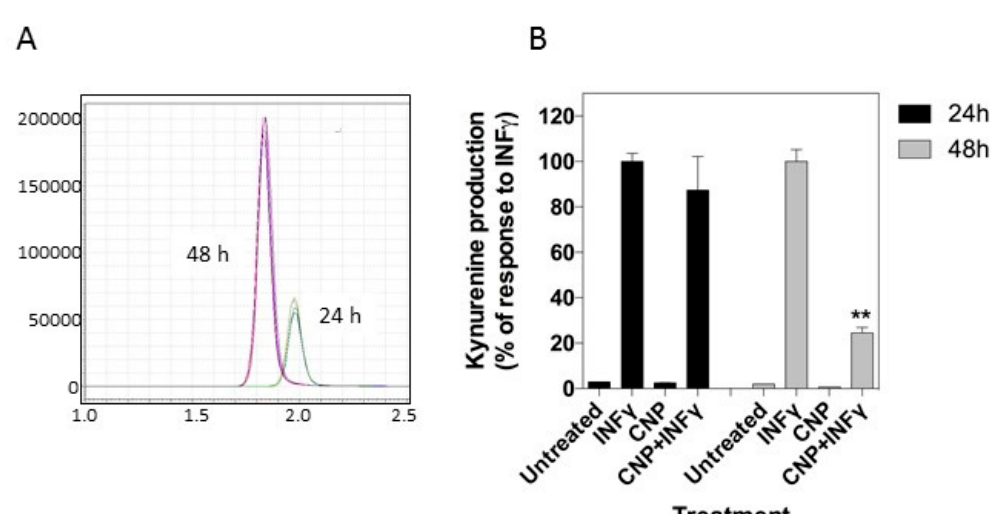
Figure 5. CNP downregulates IFN- γ -mediated tryptophan metabolism in HUVEC. ( A ) Representative chromatogram of kynurenine production following IFN- γ treatment. ( B ) Kynurenine production from untreated HUVEC or after 24 h and 48 h treatment with IFN- γ alone or in combination with CNP. Data shown are representative from a single HUVEC isolate, expressed as % IFN- γ -stimulated kyunurenine production), and performed in duplicate. (** p < 0.01, significantly different from IFN- γ alone).